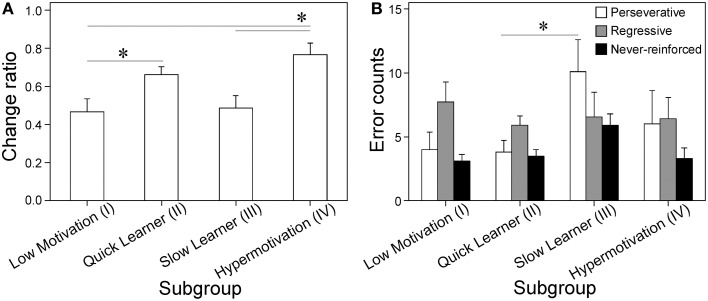
Differential sensitivity to reward devaluation and variable number of errors during set-shifting of each subgroup. (A) Change ratios of active lever response rates (lever presses/min) with the fixed ratio reward schedule (FR-1) with vs. without water deprivation (index of sensitivity to devaluating the fluid reward); Cluster I, n = 17; II, n = 36; III, n = 13; IV, n = 13 [subgroup: F(3, 75) = 4.87, p = 0.0038]. (B) Analyses of three error types (perseverative, regressive, and never-reinforced) made during set-shifting by four subgroups. Data are shown as subgroup mean + SEM (data located outside mean ± 2SD were discarded from the statistical analyses, changing the numbers of animals in each subgroups as follows; Cluster I, n = 11; II, n = 27; III, n = 11; IV, n = 7), [subgroup on perseverative error: F(3, 52) = 3.04, p = 0.037; regressive error: F(3, 52) < 1; never-reinforced error: F(3, 52) = 3.02, p = 0.038]. *p < 0.05, between relevant subgroups.